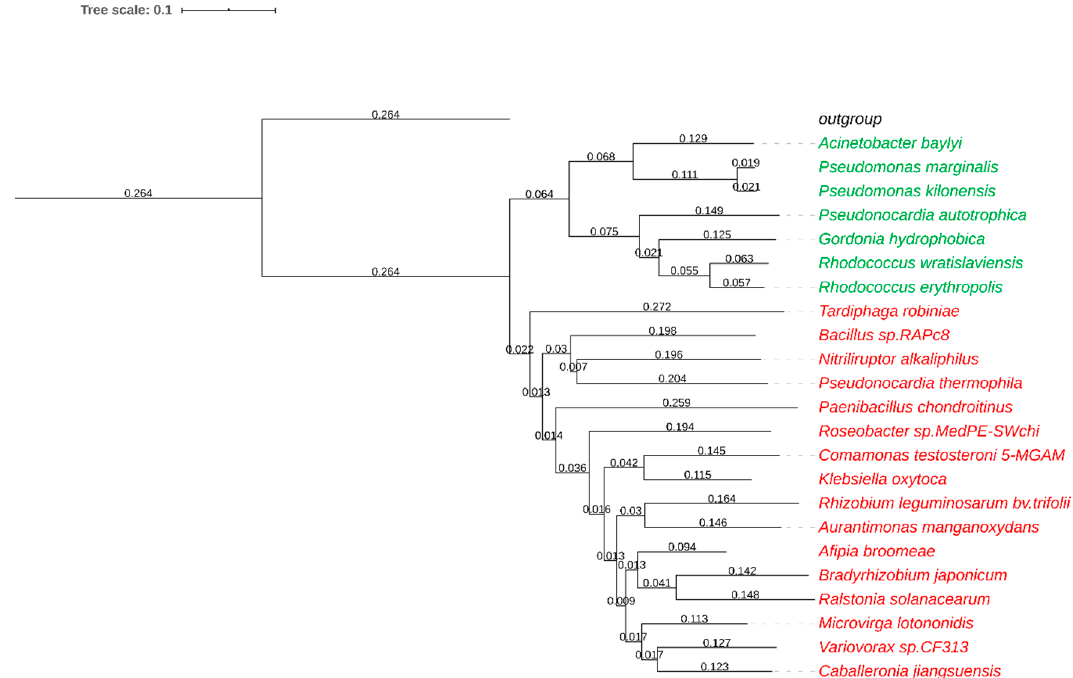
Figure 2. Phylogenetic relationship of nitrile hydratase (NHase) α -subunits based on a protein distance analysis with T-COFFEE (Version_11.00.d625267) and visualization with iTOL (Version 5.5.1) [12]. Rhodococcus erythropolis amidase (Uniprot: P22984.2) served as the outgroup. Iron-type NHases are displayed in green, cobalt-type NHases in red.